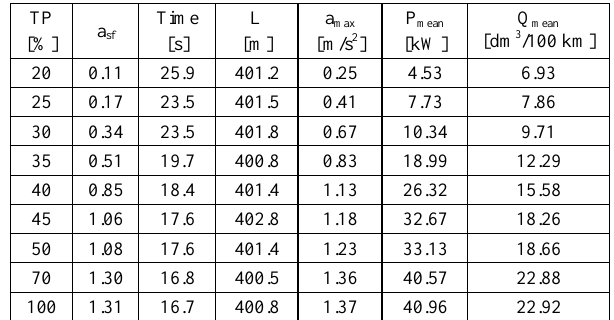
Table 1. List of dynamic and energy parameters for the acceleration pro- cess in ¼ mil